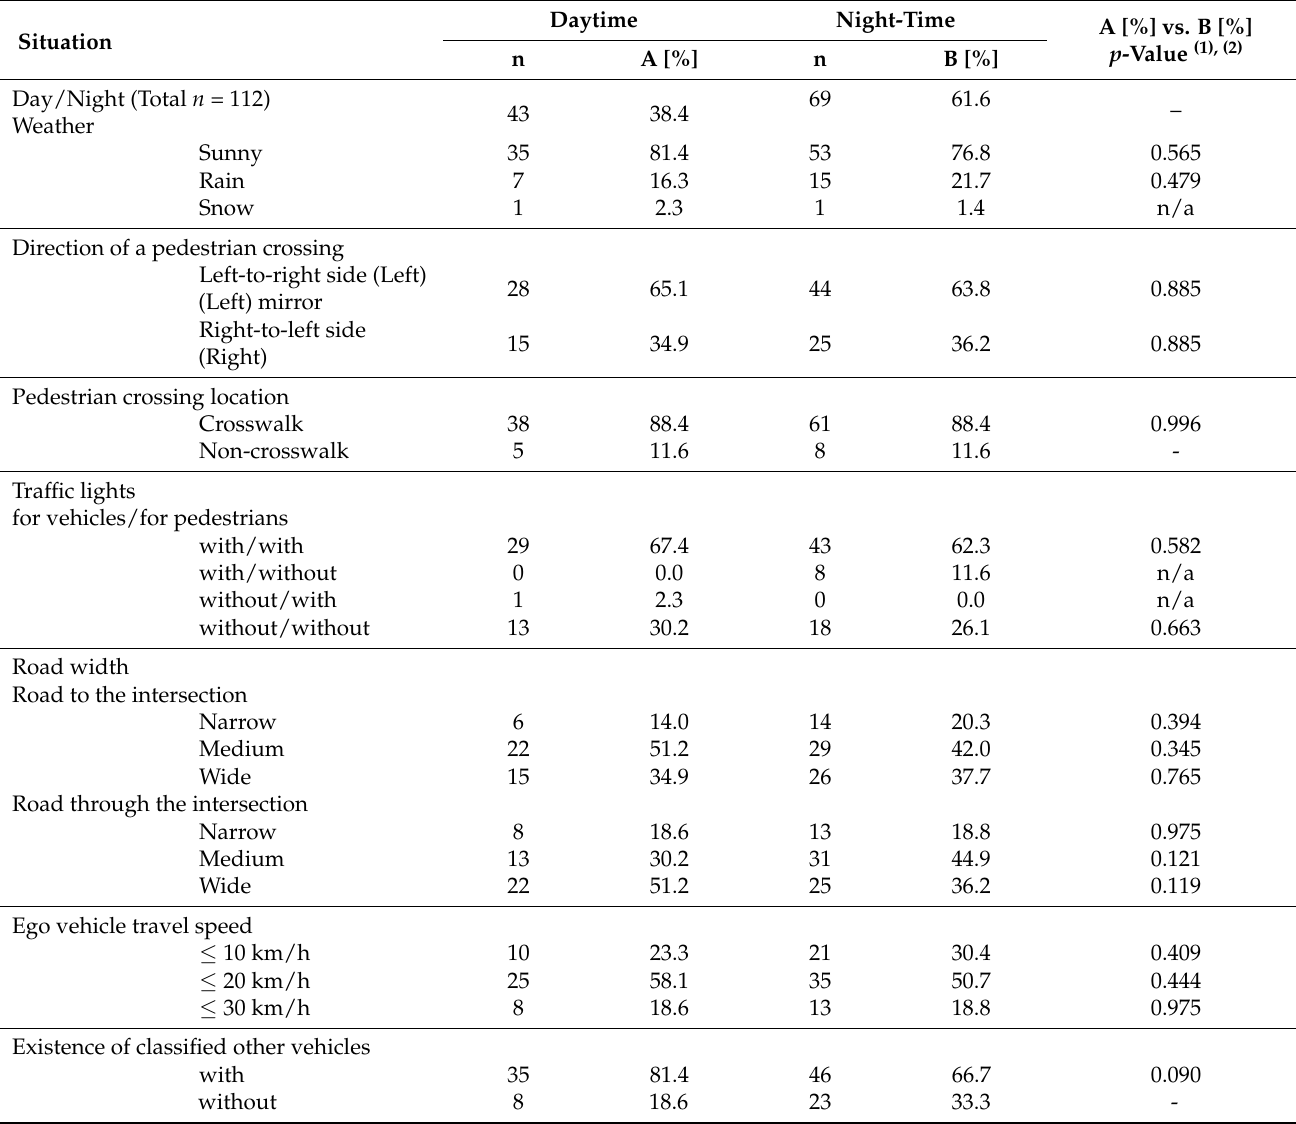
Table 2. Statistical significance of differences in the distribution of near-miss incidents between right-turning vehicles and pedestrians during daytime and